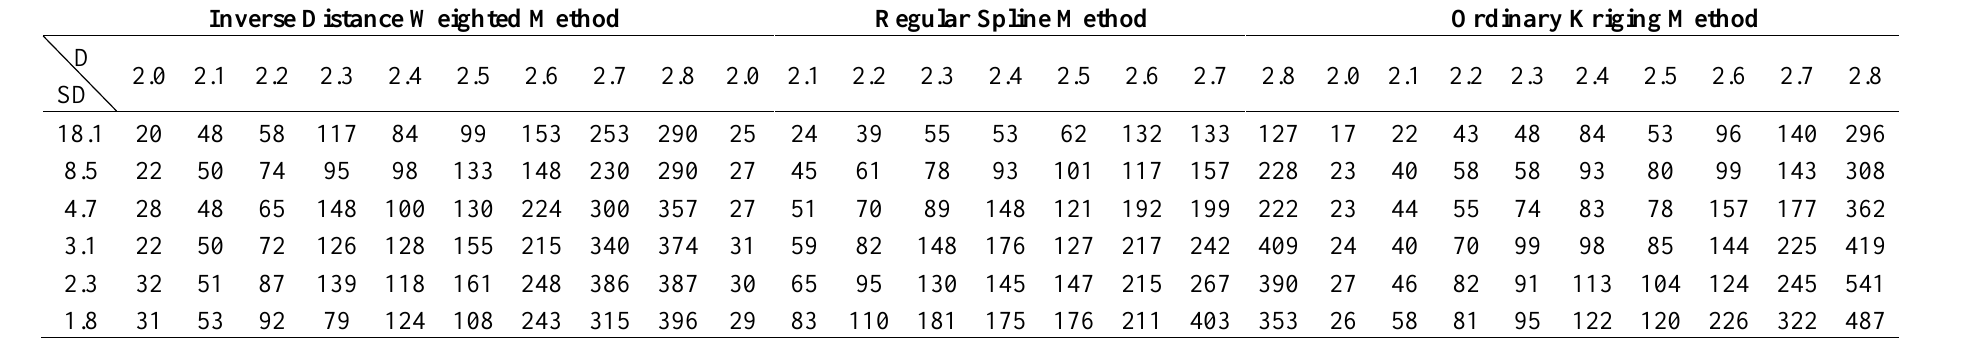
Table 3. The MAX s under combined sampling mode (Unit: m).